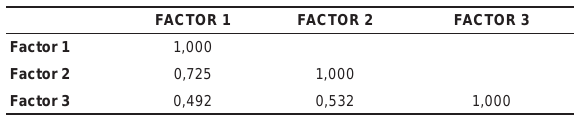
TAbLE 19 Matrix of factor